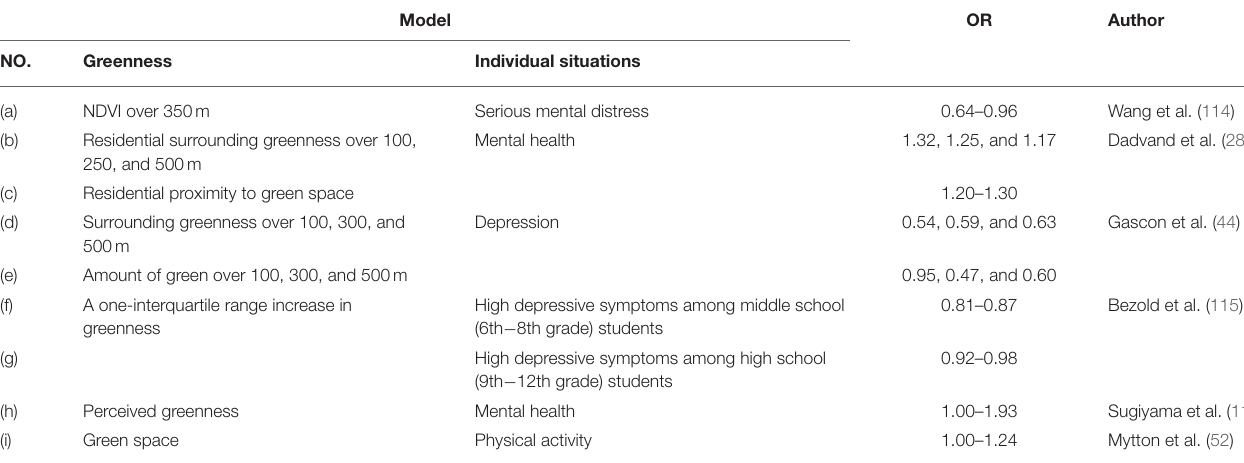
Table A1 | Odds ratios (ORs) for the association between greenness and individual